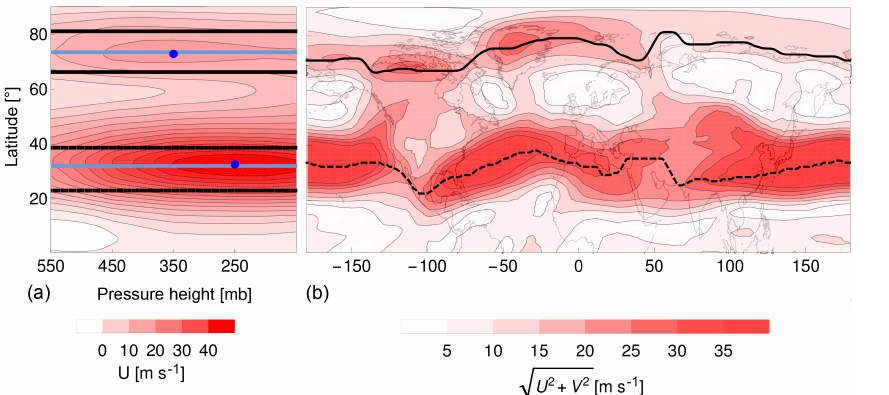
Figure 5. Fifteen-day running mean around 13 January 2010. Jet stream cores calculated with Dijkstra’s algorithm using optimized weights (compare with Fig. 2).